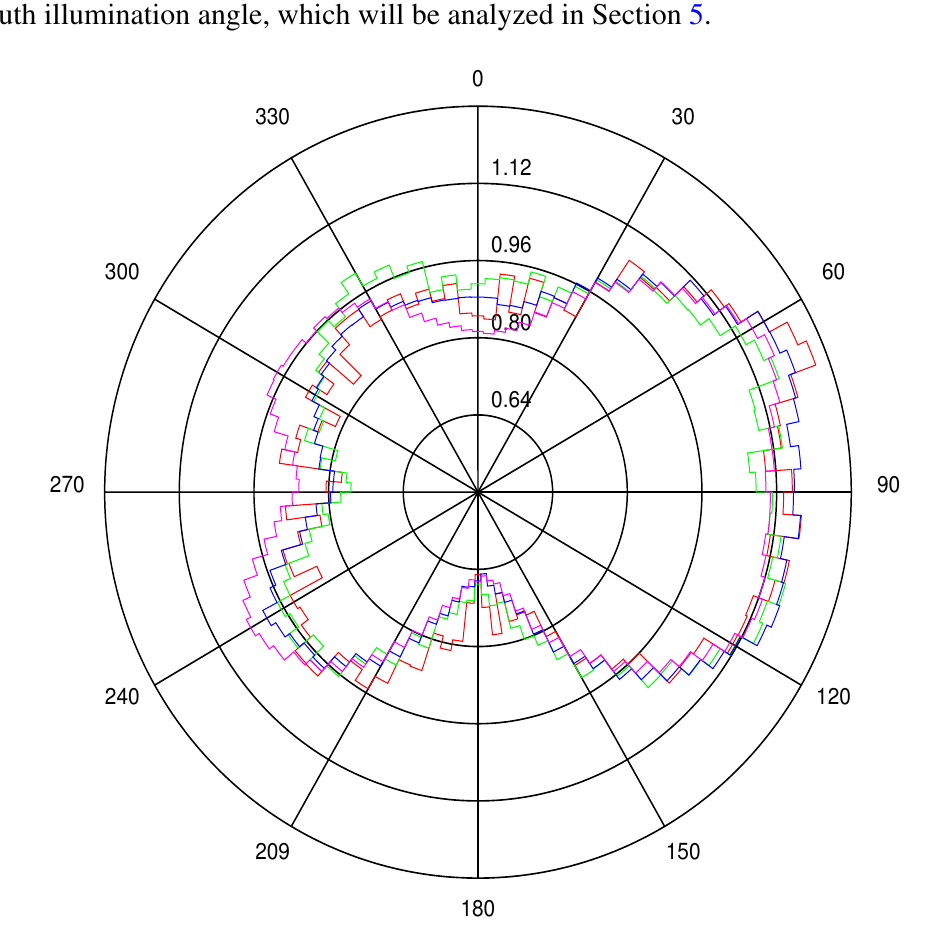
Figure 4. Steep slope, i.e. , with a repose angle ranging between 15 ◦ and 35 ◦ , azimuth direction relative frequency distribution over the four ROIs: 10 km × 10 km (red line), 20 km × 20 km (green line), 50 km × 50 km (blue line) and 100 km × 100 km (magenta line). Circles represent the relative frequency (%) of slope azimuth angles, and polar angles represent the azimuth with zero value pointing to the